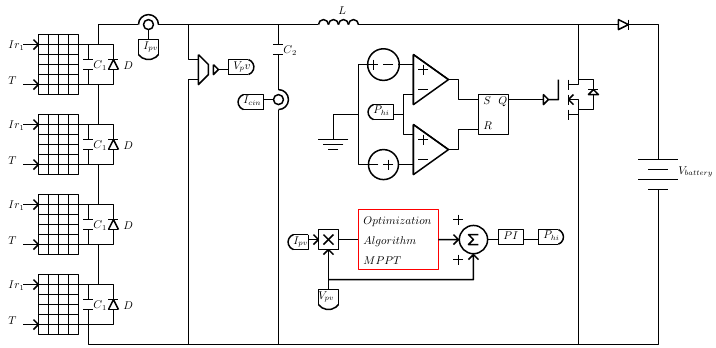
Figure 10. Assembly in PSIM @ with four photovoltaic panels and IPSM